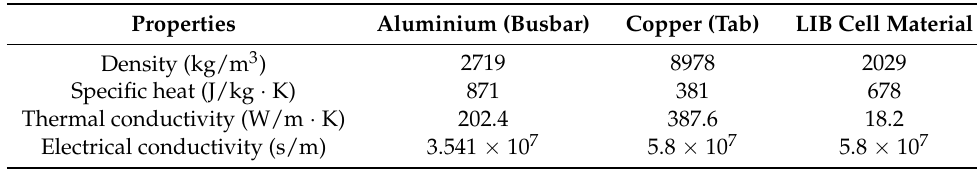
Table 1. LIB Module Component Material